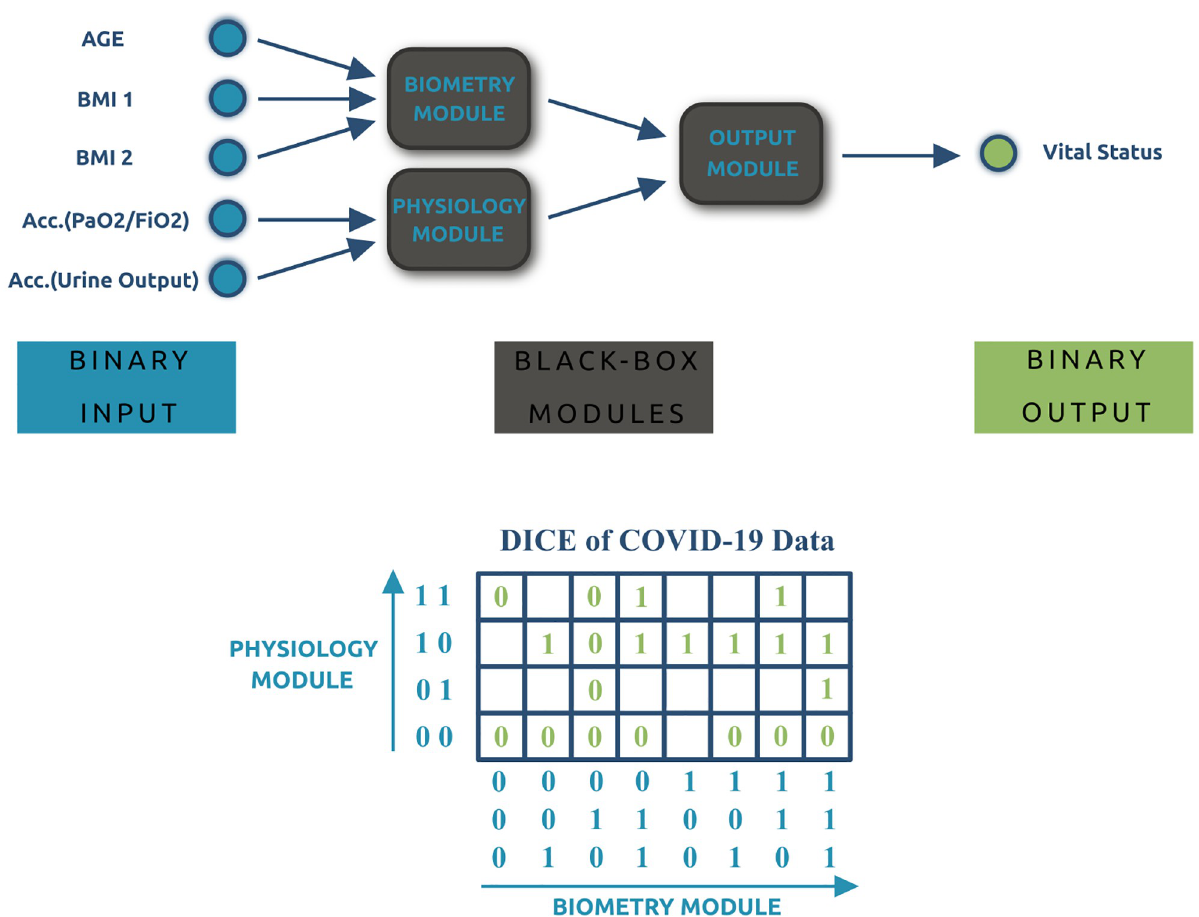
Fig 8. The SHM and the associated orthotope for the COVID-19 data. The upper figure shows the hybrid network mapping five binarized patient features to their vital status. The lower figure depicts the associated orthotope consisting of 20 cells with labels and 12 cells without a label.